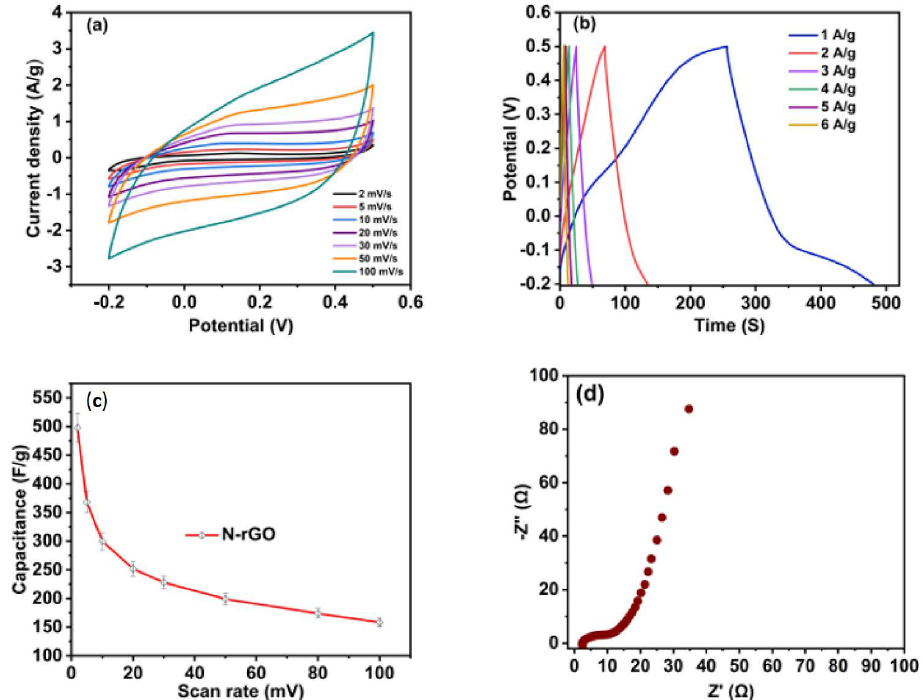
Figure 8. Electrochemical properties: ( a ) CV curves of N-rGOs, ( b ) GCD with several current densities, ( c ) variable capacitance with different scan rates, ( d ) EIS plot of N-rGO-based